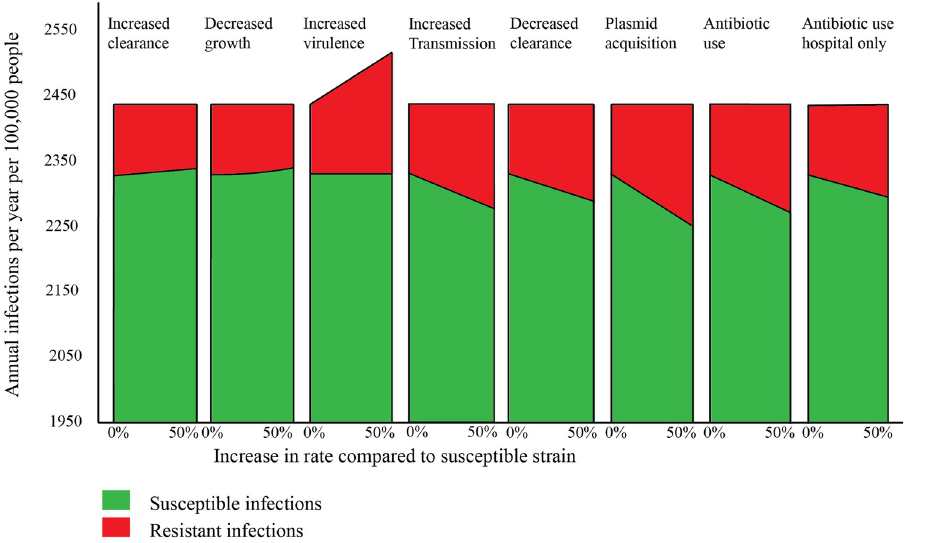
Fig 3. Annual susceptible and resistant infections per 100,000 people per mechanism in 10 years of